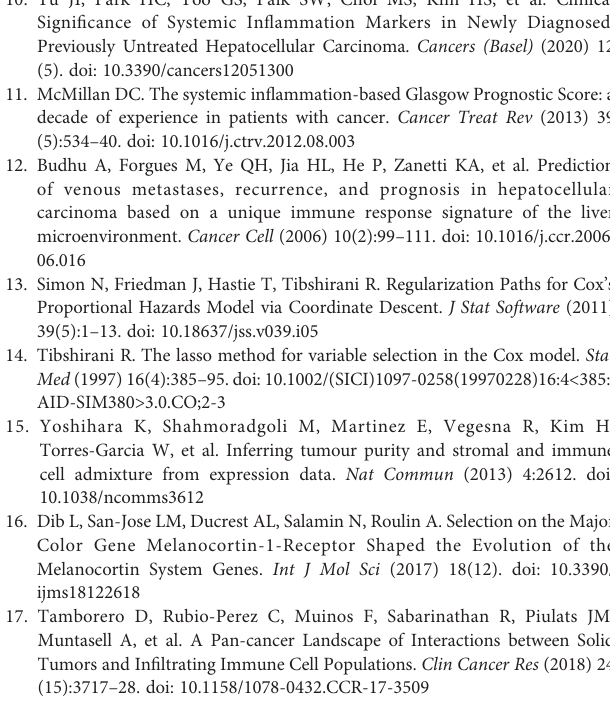
parameter ( l ) in the LASSO model was selected through ten cross-validation.